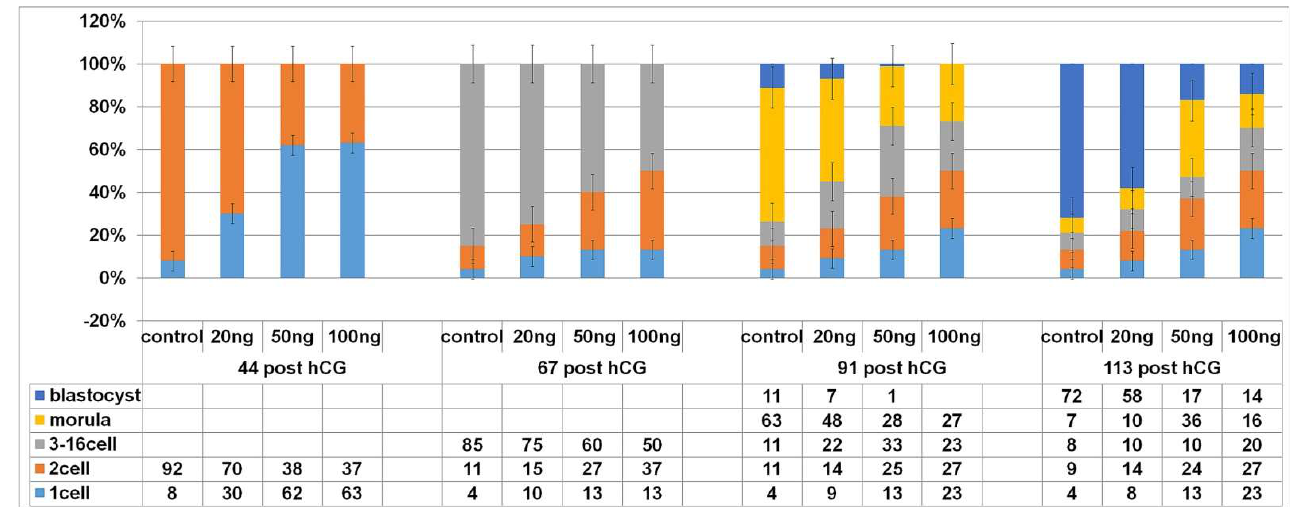
Figure 4. Cleavage ability of control and NCS-treated embryos in in vitro conditions. The data show a percentage of cleavage stages in the individual experimental groups at the periods after hCG administration. Total numbers of embryos examined in each group: control = 112; 20 ng NCS = 135; 50 ng NCS= 140; 100 ng NCS= 145. The experiment was repeated three times.